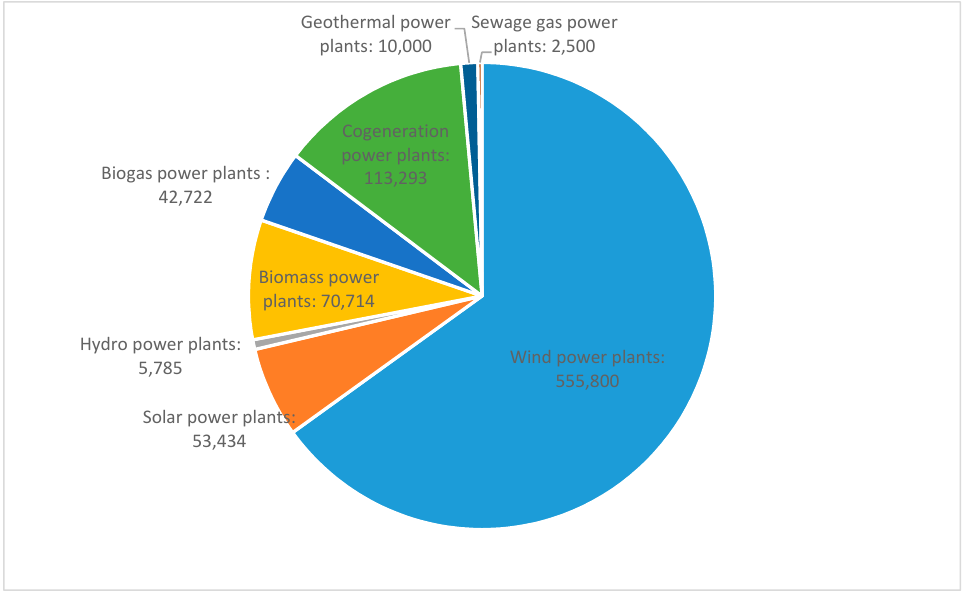
Figure 1. Renewable energy sources production in Croatia, 2019 [kW].